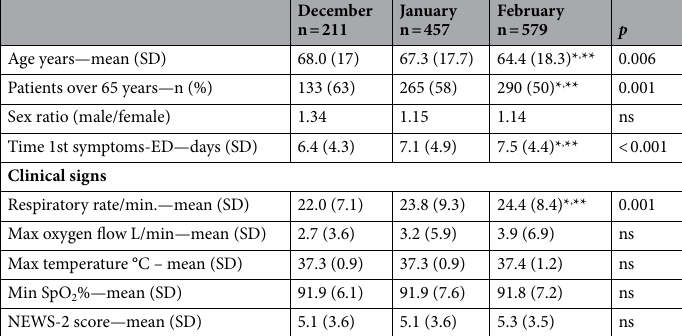
(n = 29) versus controls (n = 58) on age (61.0 ± 10.7 vs 61.6 ± 11.9 years) and gender (51.7% male in each group), we compared time 1st symptoms-ED admission and the ED NEWS-2 score (cases vs controls) respectively: